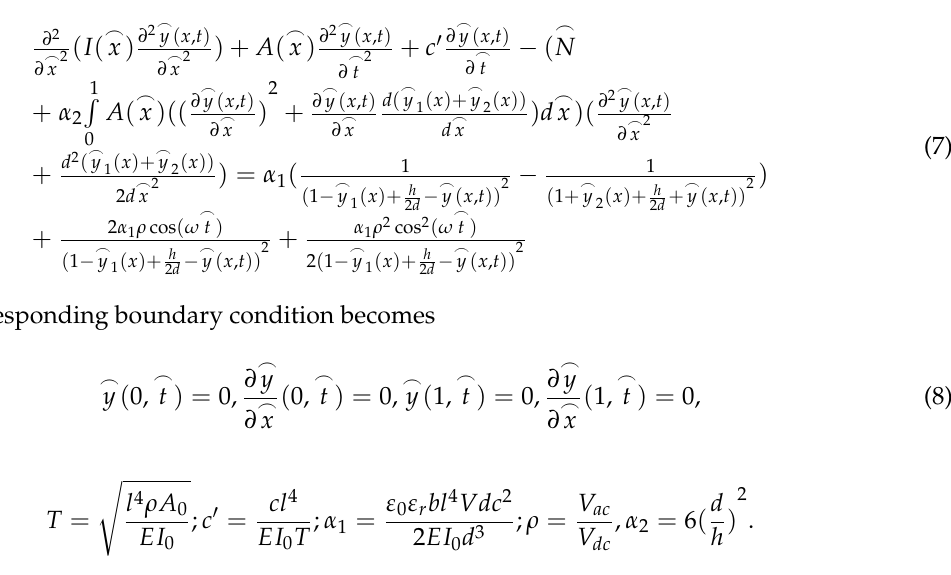
λ at =0 λ . Solid lines show 2 1